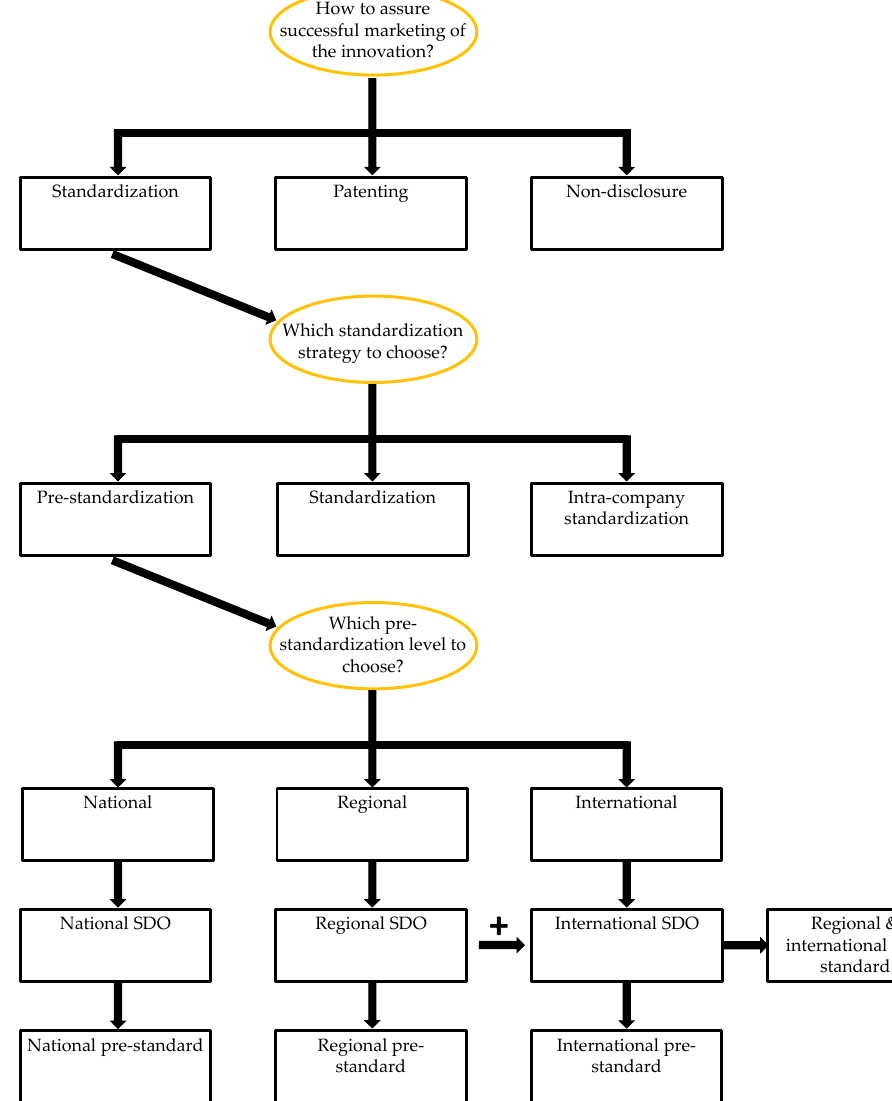
Figure 1. Key questions for corporate standardization strategies depicted in a decision tree. It assists in identifying the recognized standard-developing organization (SDO) for the elaboration of the final normative document. Regional SDOs and international SDOs can either be involved subsequently or simultaneously to yield a regional and international normative